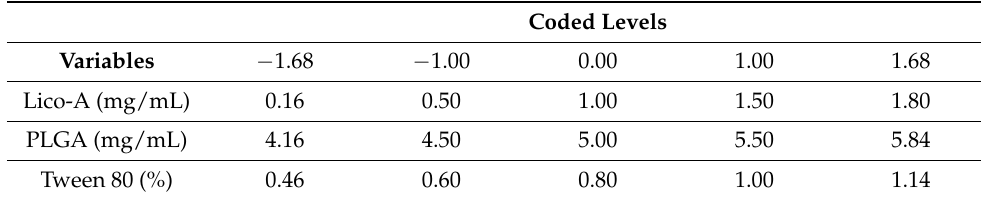
Table 1. Matrix of the factorial